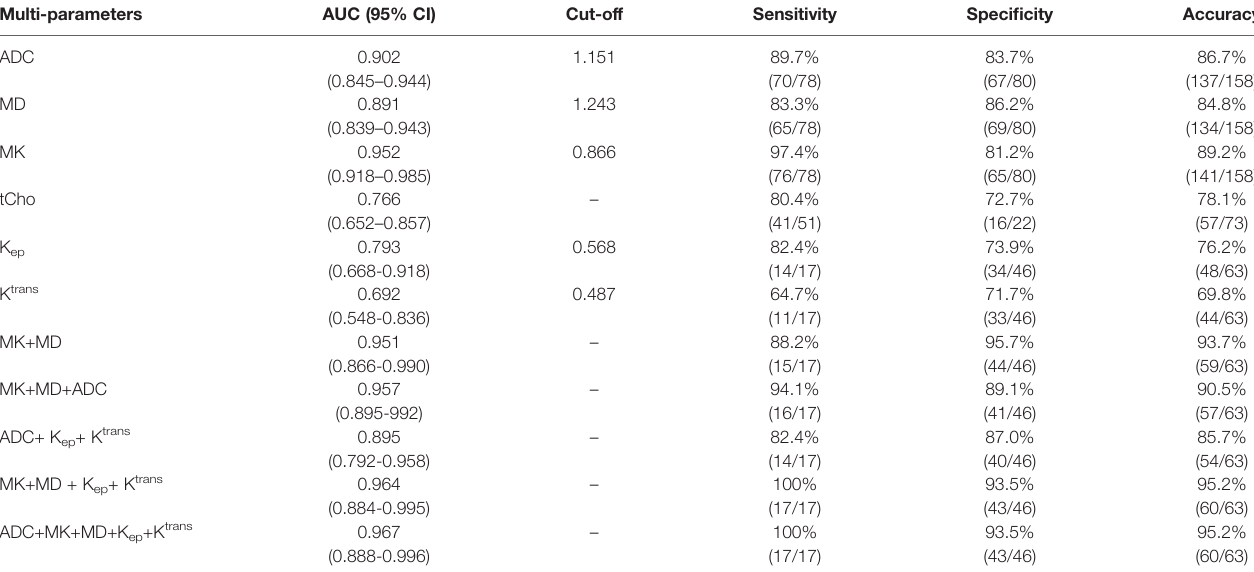
TABLE 3 | ROC analysis of the diagnostic performance for MK, MD, ADC, tCho, K ep and K trans alone or in combination for differentiation of malignant and benign lesions. Multi-parameters